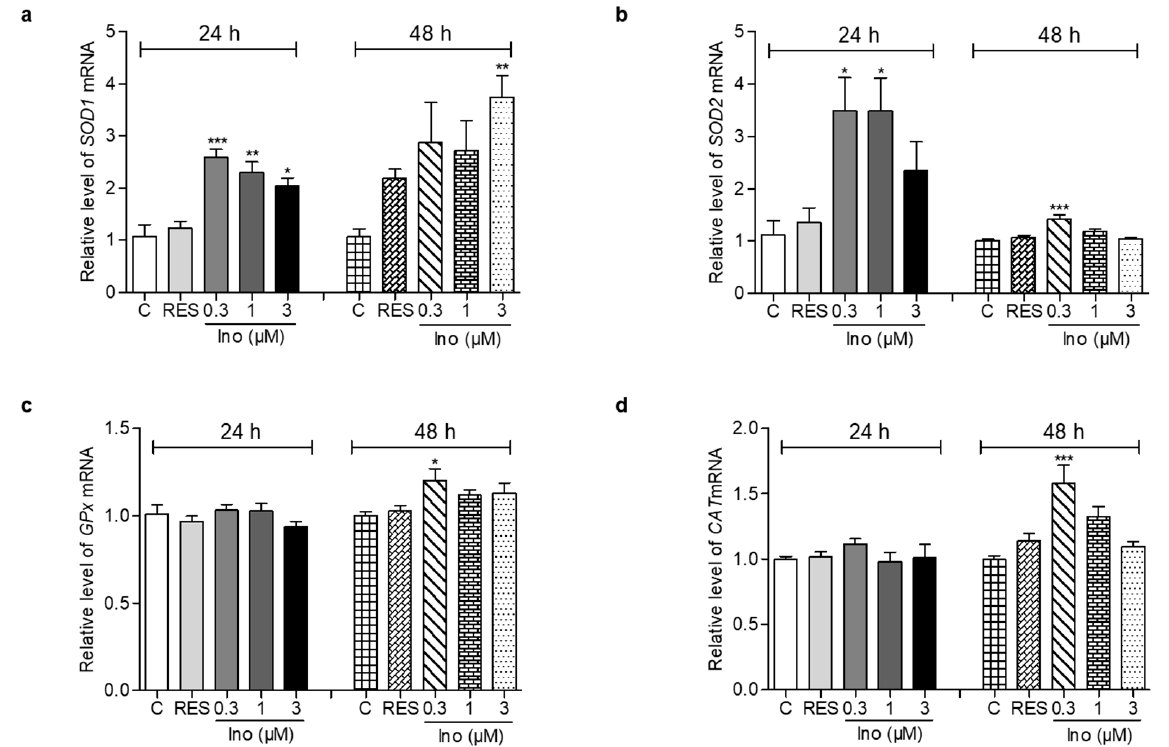
Figure 3. Effects of inokosterone on anti-oxidative-related gene expression. ( a – d ) The gene expression of SOD1 , SOD2 , GPx and CAT in yeast after treatment with inokosterone at doses of 0.3, 1 and 3 µ M for 24 and 48 h, respectively. The experiments were repeated thrice, and the data are presented as the mean ± SEM. *, **, and *** indicate significant differences from the control group at p < 0.05, p < 0.01, and p < 0.001, respectively.